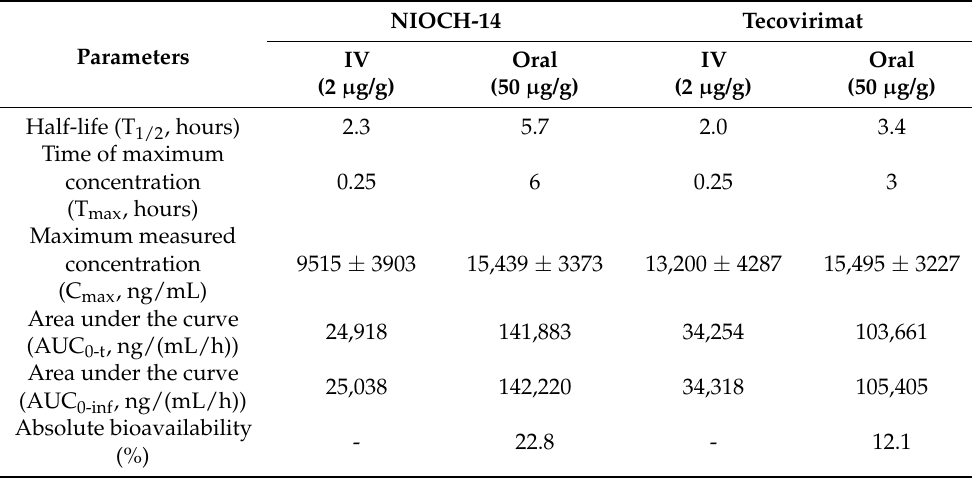
Table 6. Pharmacokinetic parameters of NIOCH-14 and tecovirimat